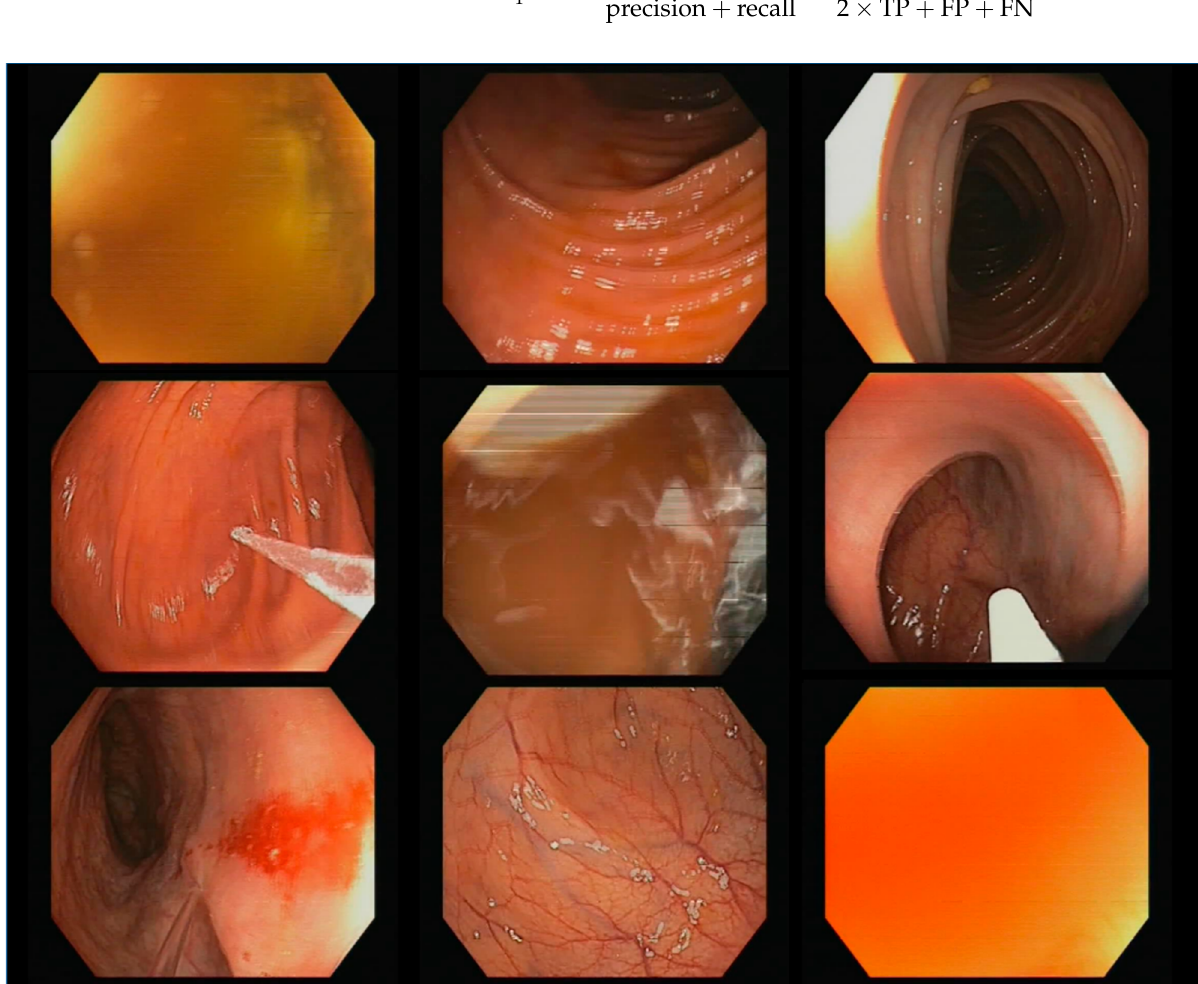
Figure 2. Random sample of the not-polyp images included in the injected datasets.